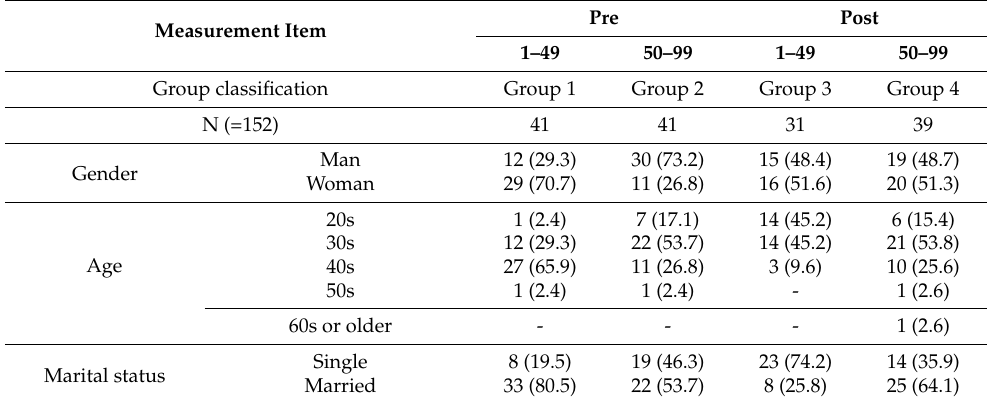
Table 6. General consumers: demographic profile of respondents in the posttest-only control group